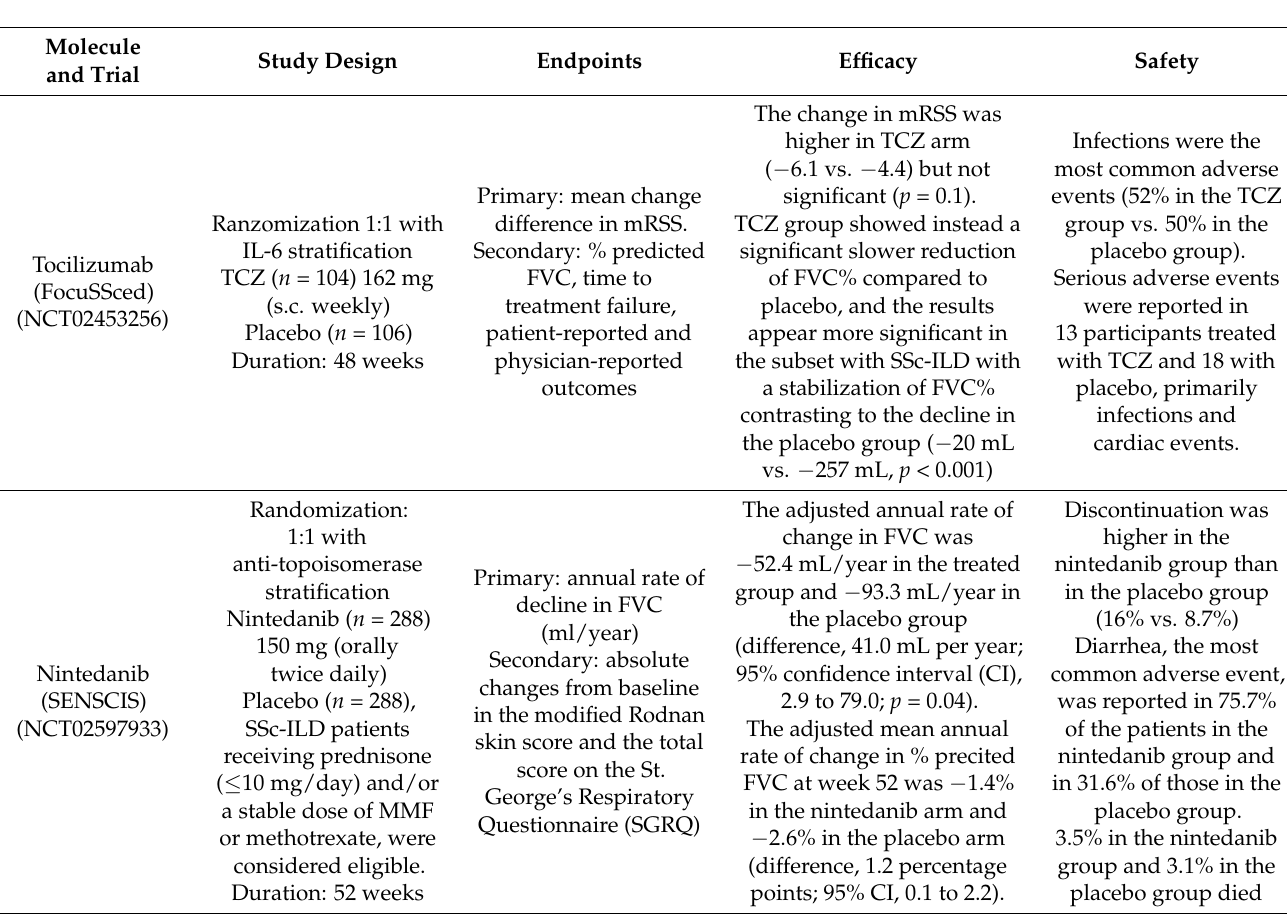
Table 2. Phase III randomized double-blind clinical trials in